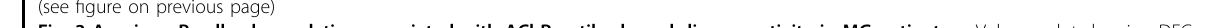
Fig. 3 A unique B cell subpopulation associated with AChR antibody and disease activity in MG patients. a Volcano plot showing DEGs between MG patients and HCs. DEG: |log fold change| > 0.5; P value < 0.05 was calculated using DESeq2. b Enrichment analysis of DEGs from B cells between MG patients and HCs (selected among upregulated pathways in MG patients, P value < 0.05). c , d CD180 − B cells are increased in MG patients. e , f CD180 − B cells are the major IgG secreting cells in MG patients and HCs. CD180 − IgG cells are signi fi cantly higher than CD180 + IgG cells in MG patients. g Circulating CD180 − B cells are associated with disease activity. h Circulating CD180 − B cells are associated with titers of anti-AChR antibodies. i Immunotherapy decreases CD180 − B cells and is associated with improved disease